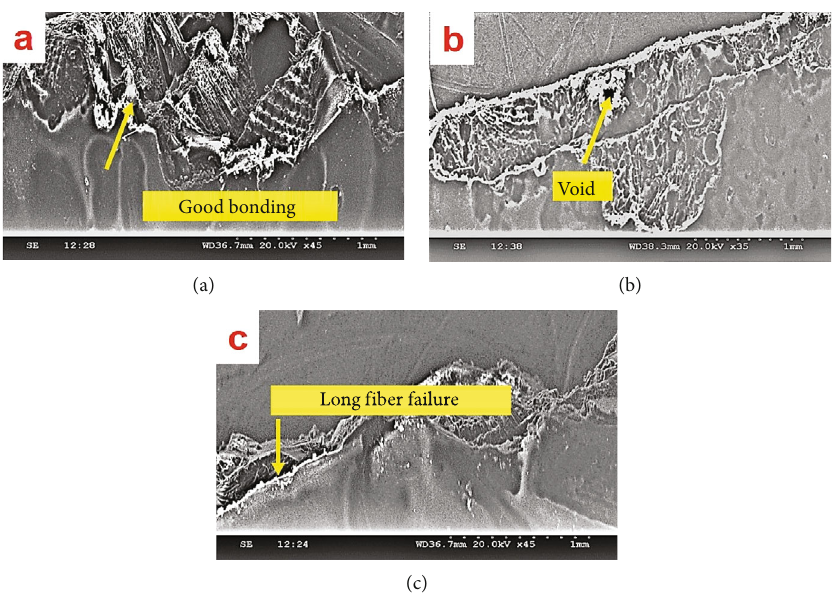
Figure 6: SEM image of cryogenic handling of the composite